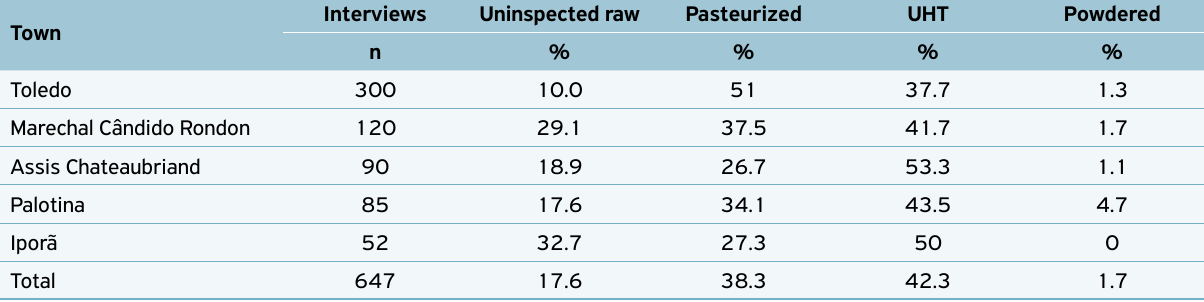
Table 1. Preferred type of milk in 647 interviews carried out from January to August 2013, according to the town. Town